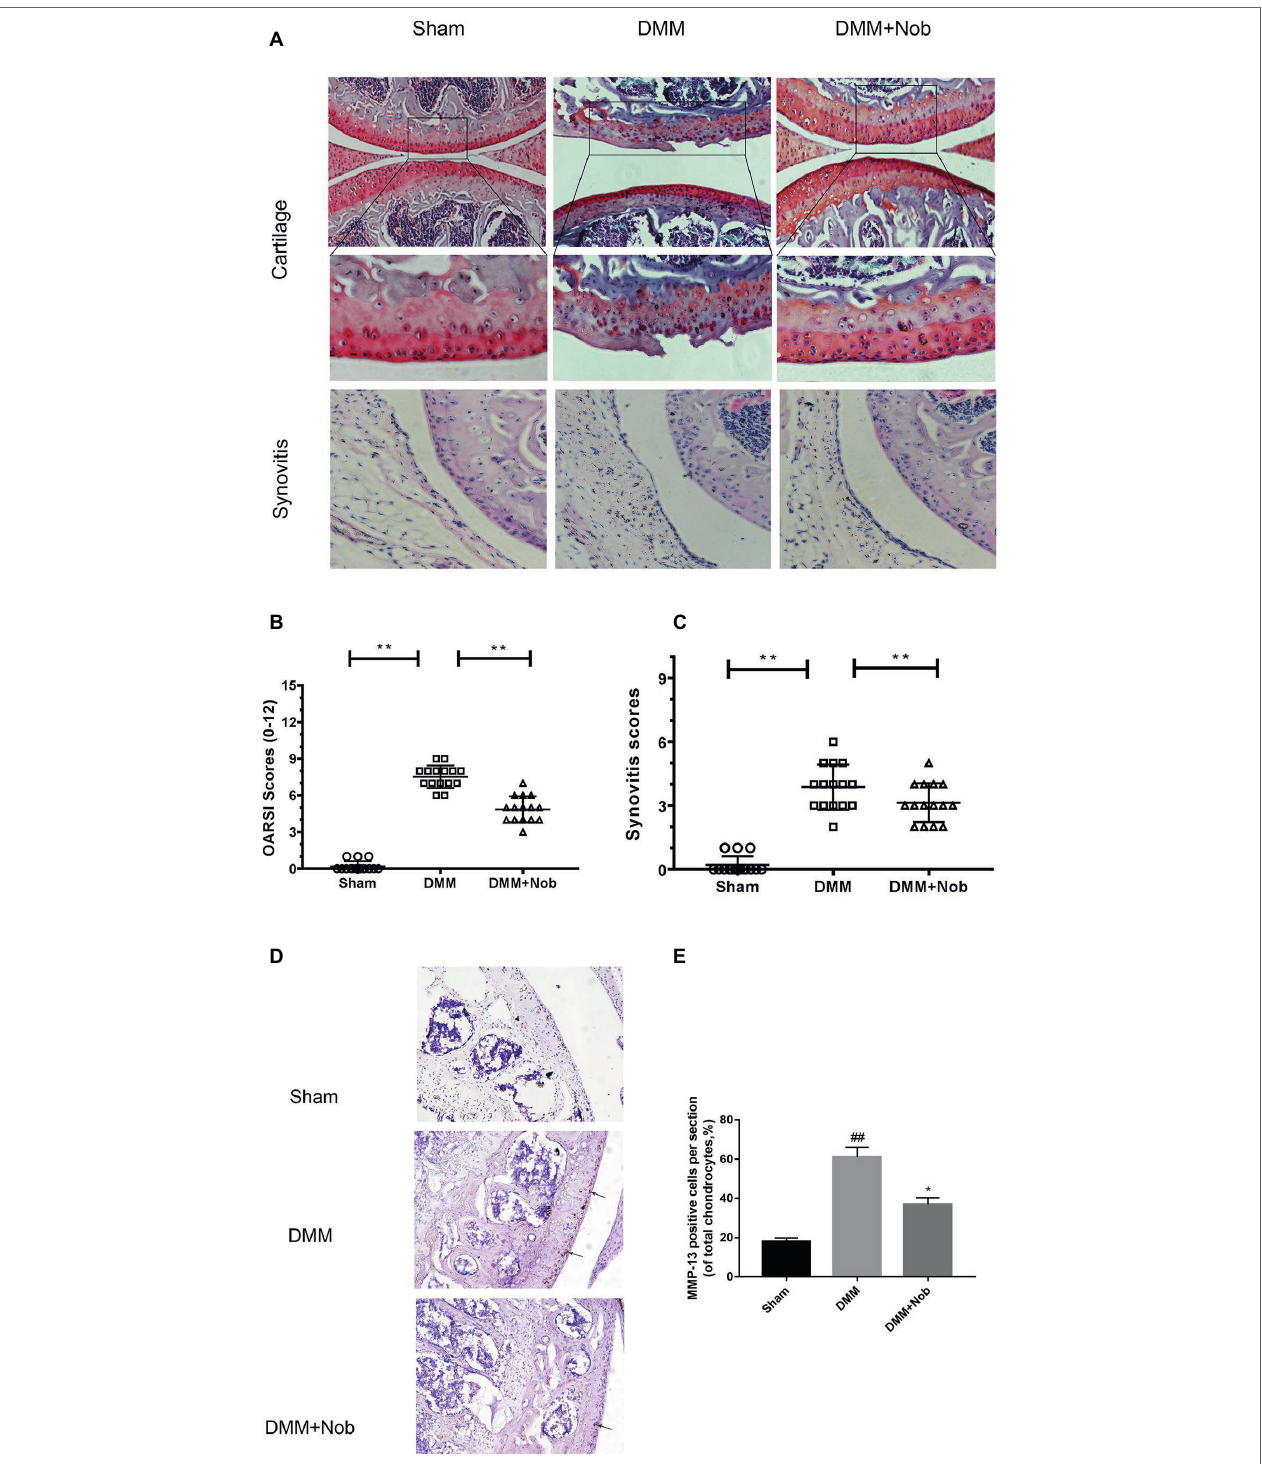
FIGURE 9 | Nobiletin suppressed degradation of cartilage in a mouse model of OA. Safranin O staining was used to assess histomorphometric differences between the sham, OA, and OA + nobiletin groups. Mice received intraperitoneal injections of nobiletin (20 mg/kg) or an inert vehicle (DMSO) in the 8th week after surgery. Histological analysis of OA was evaluated by Safranin O staining (A) and hematoxylin and eosin (H&E) staining for synovitis, Osteoarthritis Research Society International (OARSI) scores (B) , and synovitis scores (C) . Immunohistochemistry of MMP-13 was assessed to the effect of nobiletin on cartilage matrix degradation in mice OA models (black arrows indicate the examples of MMP-13 positivity). Quantification of MMP-13-positive cells in cartilage samples (D,E) . Significant differences are indicated as * p < 0.05, compared with control group. * p < 0.05 and ** p < 0.01, compared with OA group, n = 15. ## p < 0.01, compared to the control